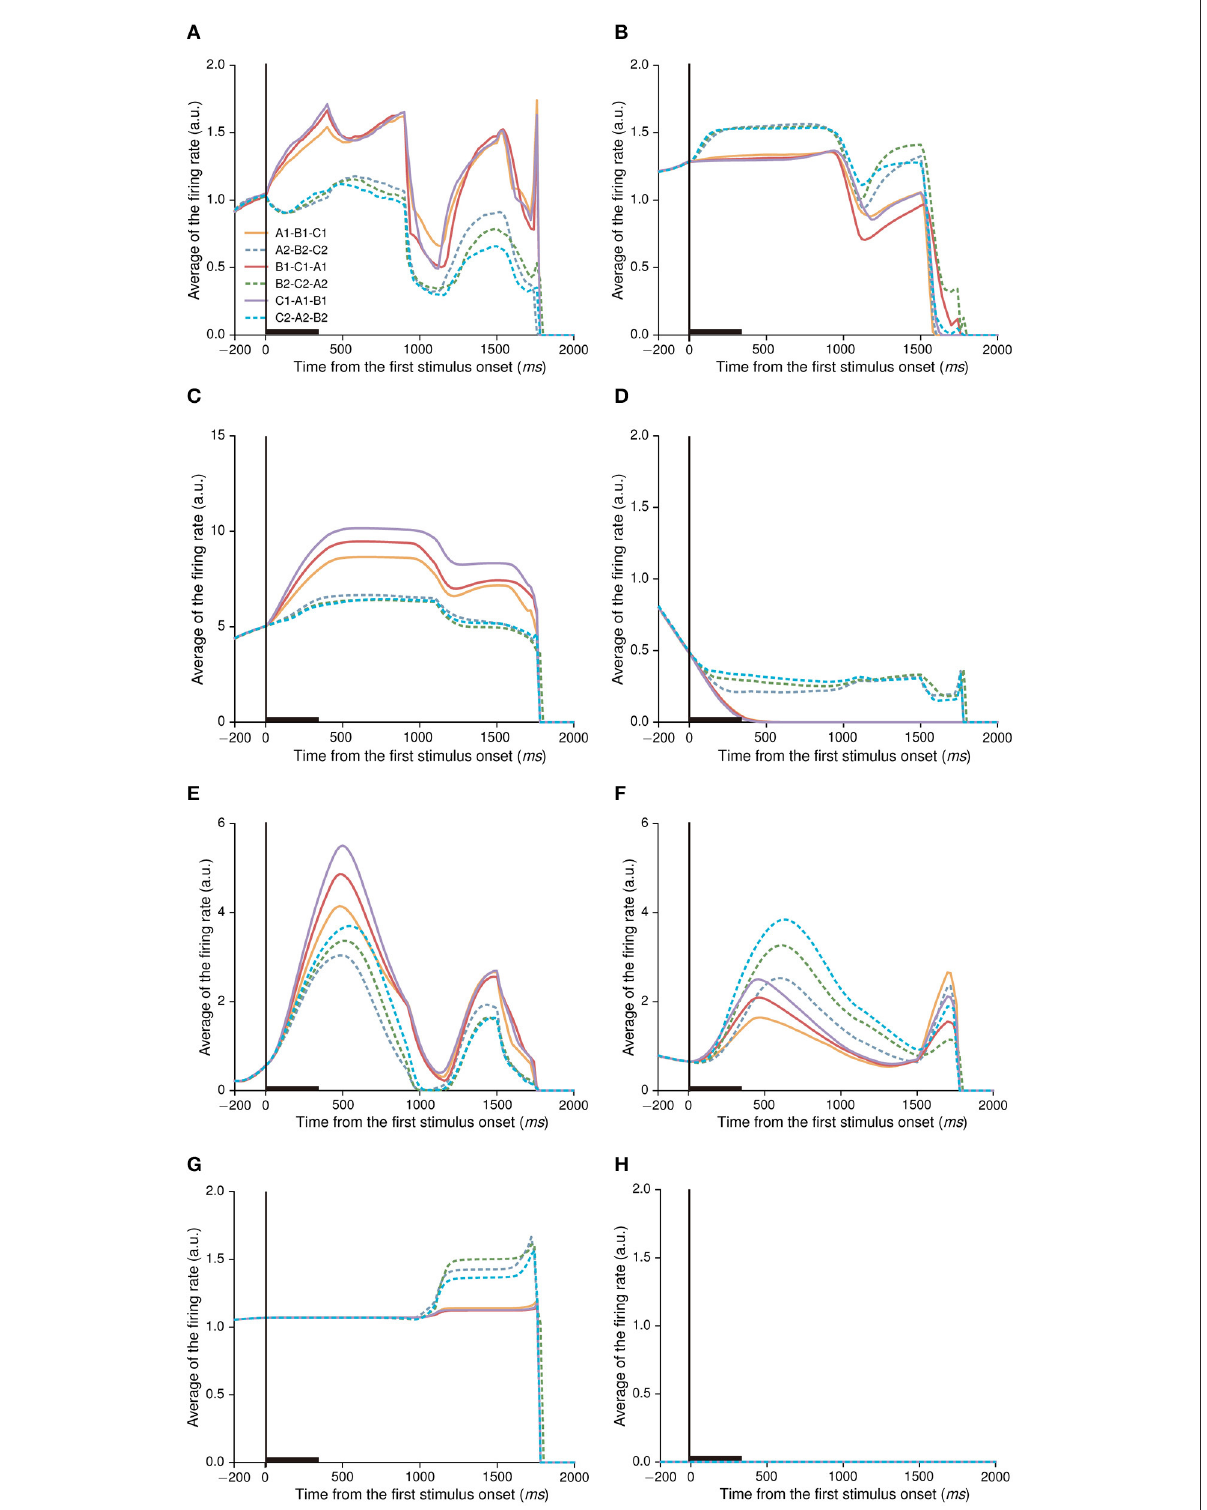
FIGURE4 Various types of activity-patterns found in the IIL of the policy network after the model learned the task. Here, the black rectangle on the horizontal axis denotes the first stimulus period (0–400ms from the first stimulus onset). During the first stimulus period, neurons show